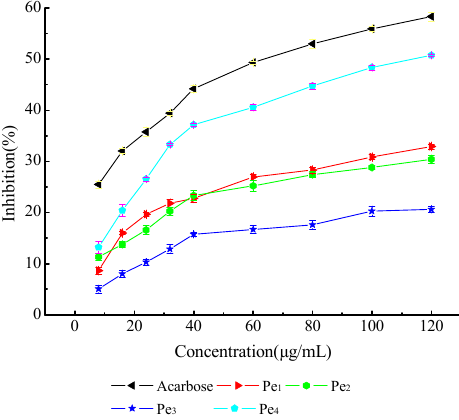
Figure 9. Dose–response curves of α -glucosidase inhibitory activity of four purified polysaccharides (Pe1, Pe2, Pe3 and Pe4).